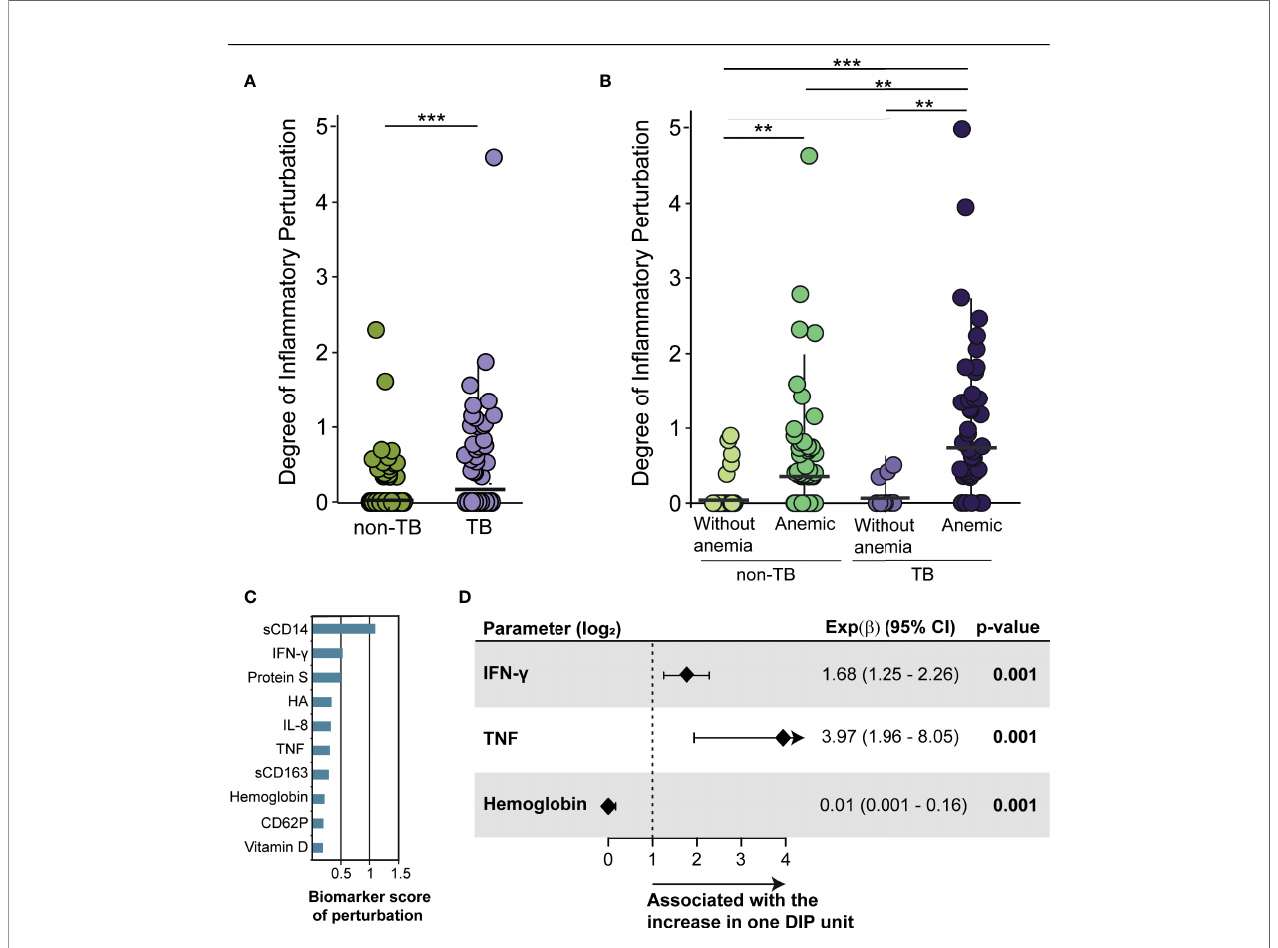
FIGURE 3 | The degree of in fl ammatory perturbation increases in anemic participants. (A) Scatter plots of the degree of in fl ammatory perturbation (DIP) by sample in the main groups: non-TB (green) and TB (purple); (B) Scatter plots of DIP by sample in each group: non-TB non-anemic, used as control (light green); non-TB anemic (dark green); TB non-anemic (light purple); and TB anemic (dark purple). DIP score values were compared between groups according to TB and anemia status. Lines in the scatter plots represent median values and data were compared using the Mann – Whitney U test. **p < 0.01; ***p < 0.001. (C) Top 10 biomarker score of perturbation in the comparison non-TB vs TB. The score was obtained using DIP approach. (D) Poisson regression to identify biomarker measurements independently associated with increases of DIP score in HIV-TB participants. All parameters are log2 transformed. Only signi fi cant parameters are